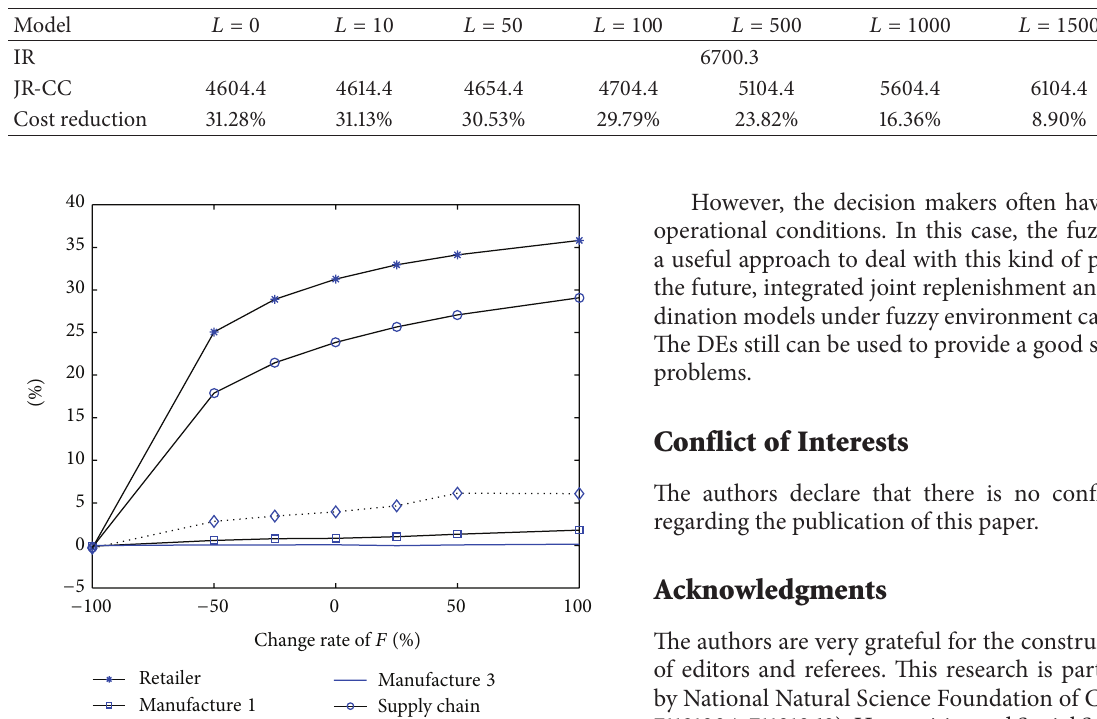
Table 9: The sensitivity analysis of coordination cost 𝐿 for the retailer.